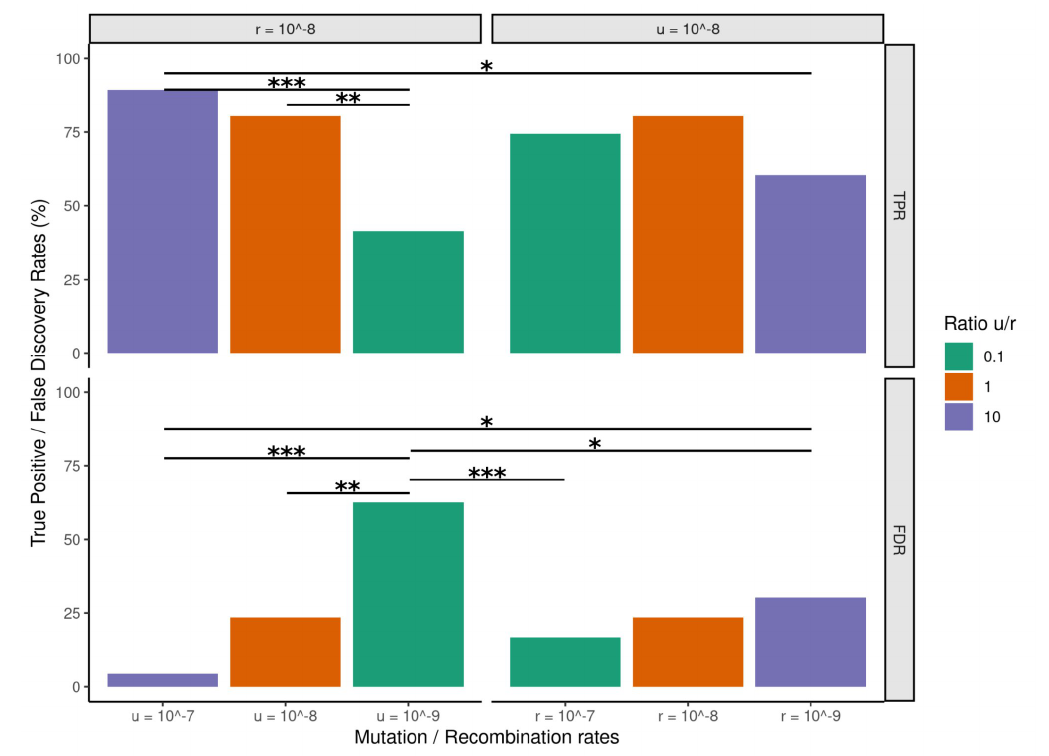
Figure 6 - Influence of the u/r ratio on hotspot detection. True positive (TP, upper panel) and false discovery (FD, lower panel) rates of hotspots called using a detection threshold of 2.5. The x axis indicates values of u for r =10^-8 (left panels), and values of r for μ =10^-8 (right panels). Colors correspond to different values of the μ / r ratio. Asterisks show significant differences in percentages between comparisons (* prop.test p-value<0.05, **<0.01, ***<0.001).